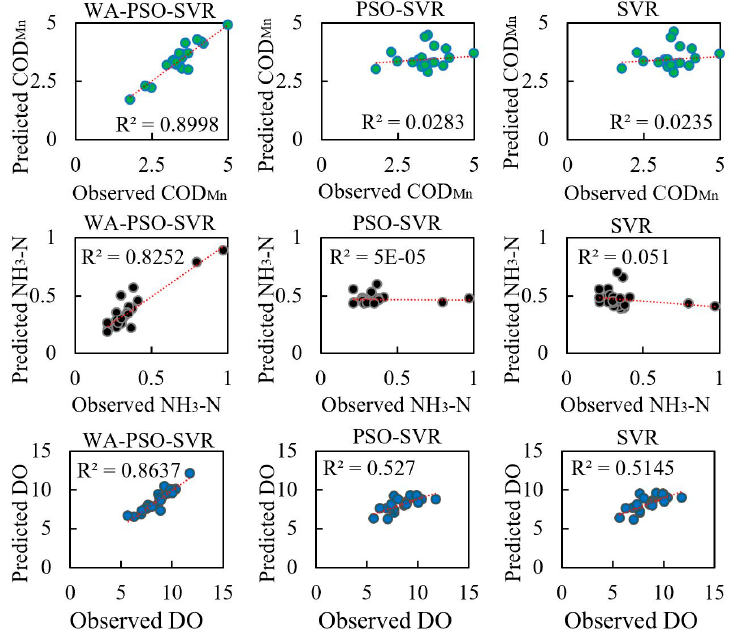
Figure 9. Scatter plots of predicted versus observed values (monthly data) in the testing phase.